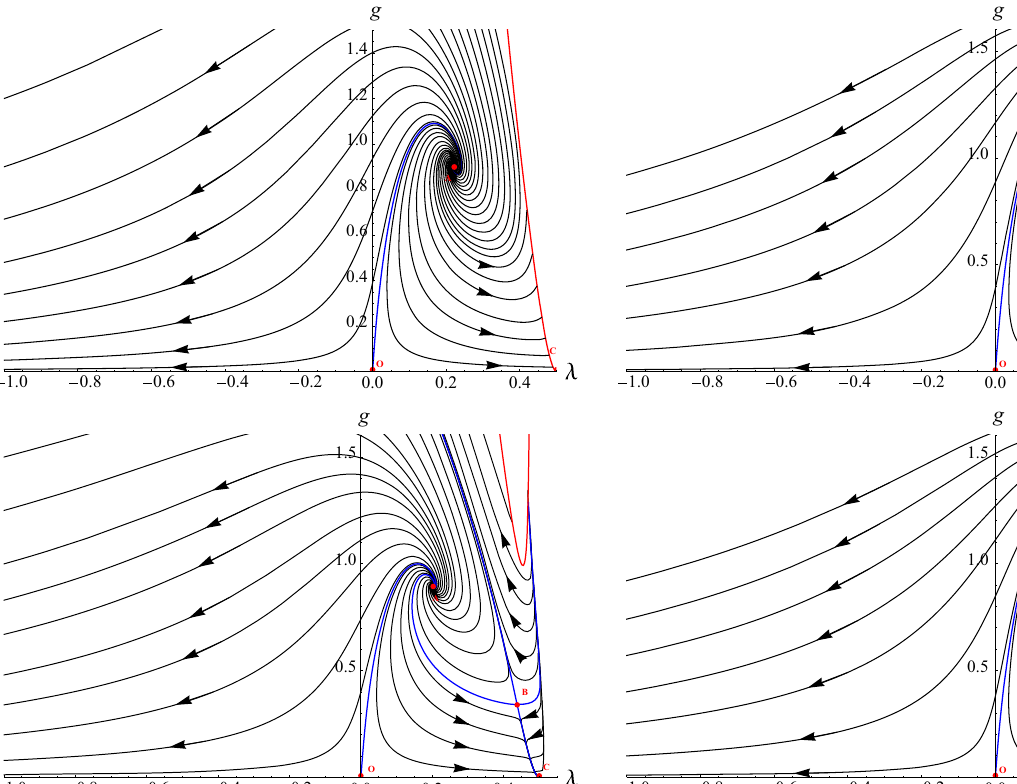
of the spatial metric ( α = 0) while the second column corresponds to an exponential split ( α = 1). All flows possess a NGFP providing the UV-completion of the RG